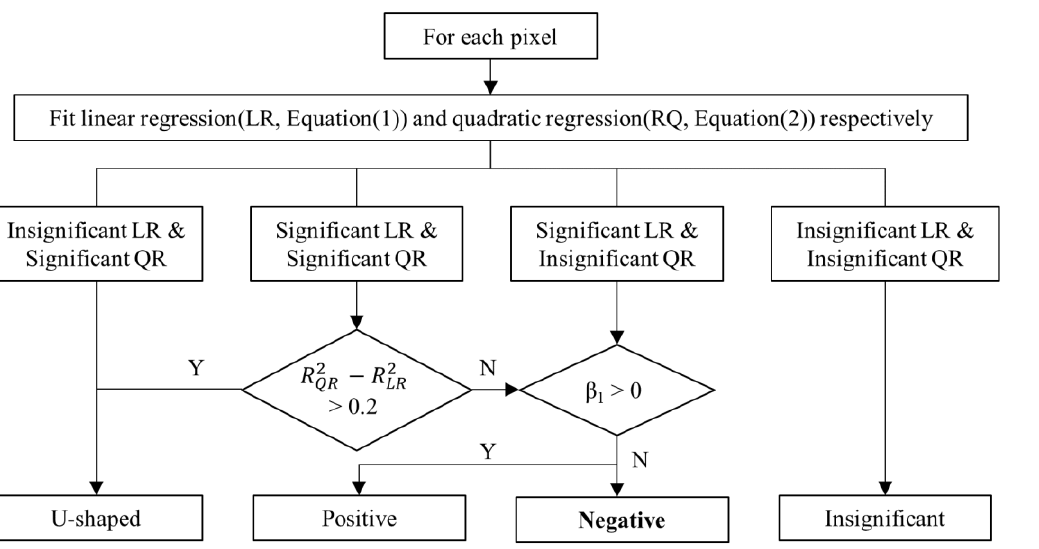
Figure 4. Quantification approach and classification